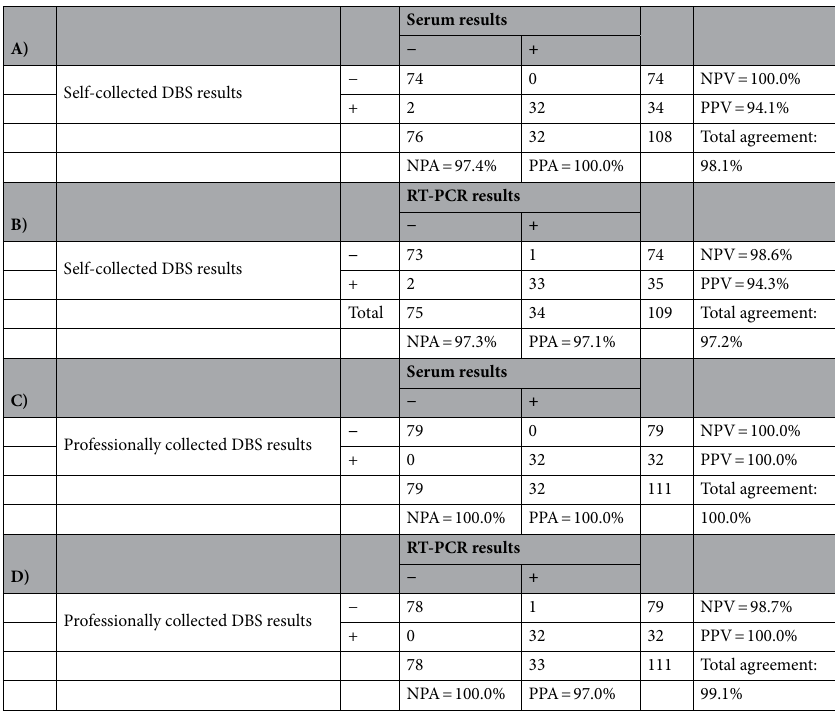
Table 3. Qualitative comparisons of self-collected DBS results to (A) serum and (B) RT-PCR results and professionally collected DBS results to (C) serum and (D) RT-PCR